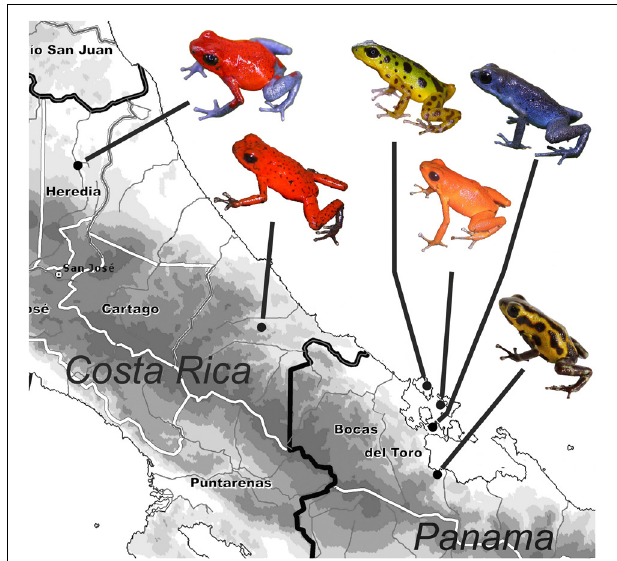
FIGURE 1 | Geographic distribution of the studied populations of O. pumilio in Costa Rica (Sarapiquí: red with blue legs; Hitoy: red morph) and Panama (Mainland: Río Gloria: yellow-black morph; Tierra Oscura: blue morph; Islands: Isla Colón: green-black morph; Isla Solarte: orange morph) with one representative frog for each